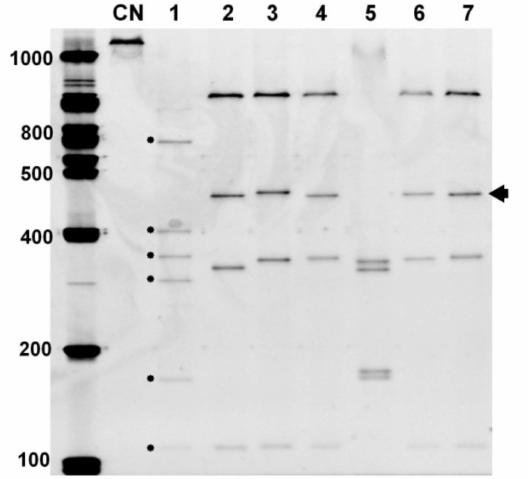
Figure 2. DNA digestion of PCR products from A m x alleles of the materials evaluated using Hae III endonuclease. The band size of the molecular weight marker is expressed in bp. Lanes are as follows: 1 , common wheat cv. Cheyenne; 2 , PI 427498; 3 , PI 427497; 4 , PI 427622; 5 , PI 554504; 6 , PI 470720; and 7 , PI 427575. CN , cv. Cheyenne without digestion. The digestion of the Ax2* subunit from cv. Cheyenne ( ) was used as control.